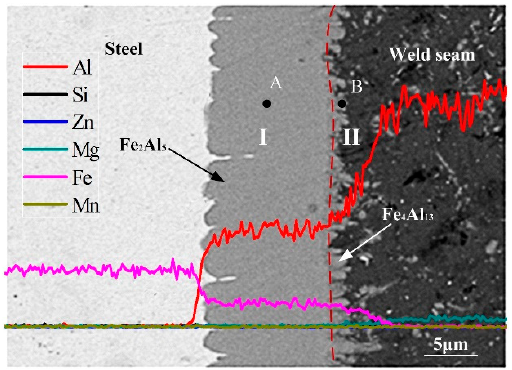
Figure 9. SEM images of the Al/Fe interface and the corresponding EDS pattern of the line scan.